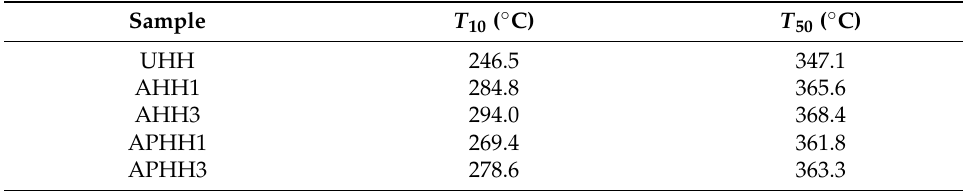
Figure 4. TGA thermograms of untreated, alkaline-treated ( a ), and alkaline/peroxide treated ( b ) hemp hurd powders, DTG thermograms corresponding to untreated, alkaline-treated ( c ), and alkaline/peroxide treated ( d ) hemp hurd powders. Table 3. T 10 and T 50 values of hemp hurd powders extracted from TGA